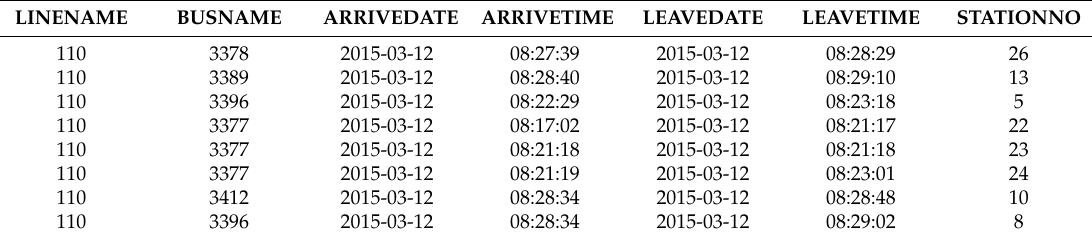
Table 3. Information used in the research among the bus IC data (sample data).